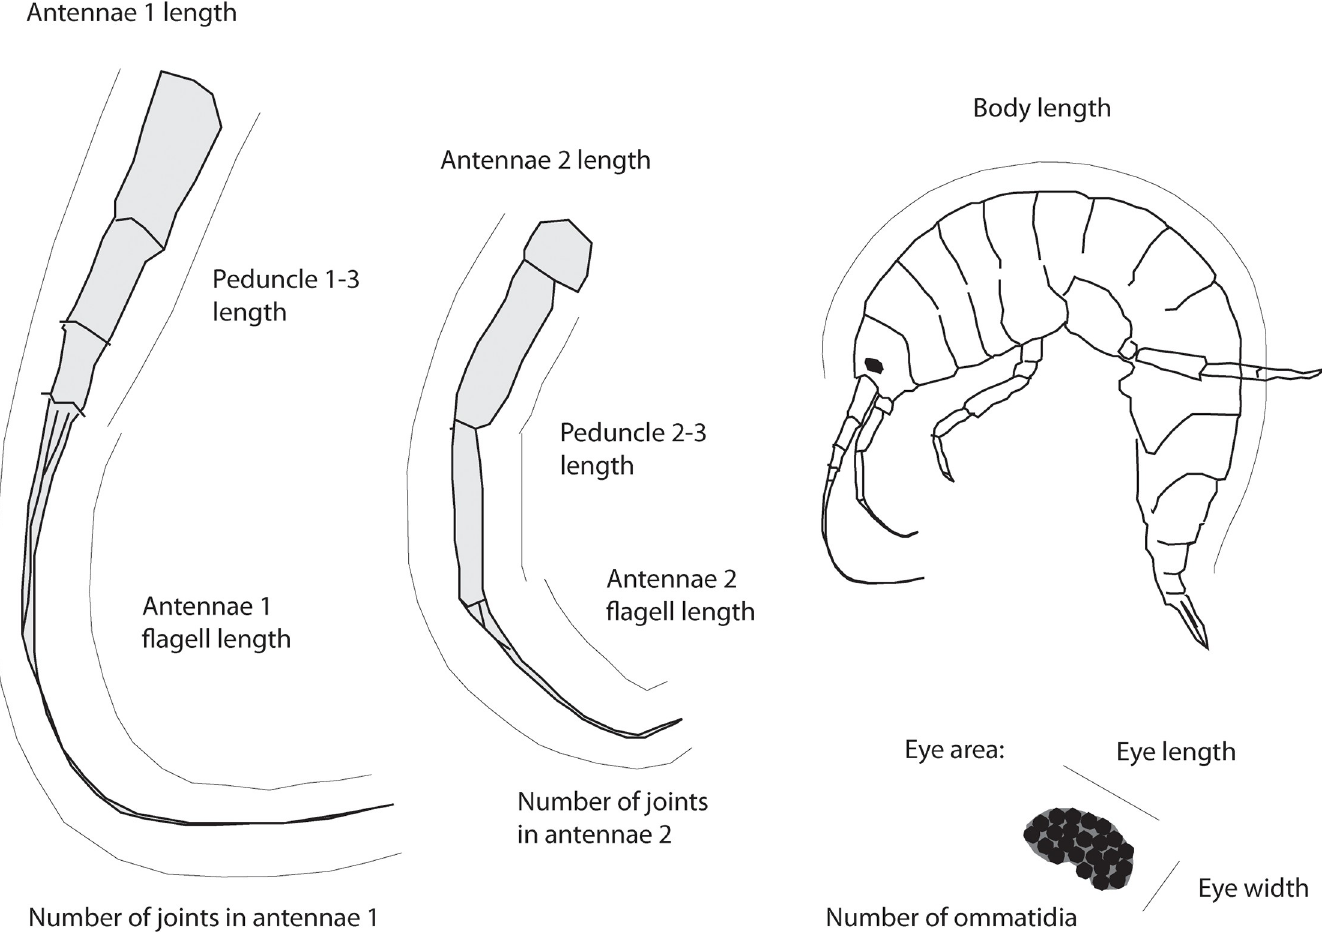
Fig 2. Morphological measurements conducted. The meristic and metric measurements scored for the three G . lacustris populations (note; only two legs have been depicted in this figure for ease of visualization).